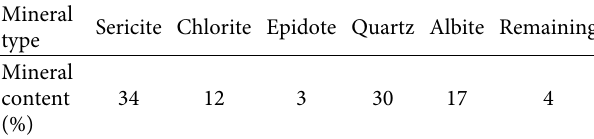
Figure 3: Detailed drawings of cracks in side walls. Table 1: Mineral types and contents of rock